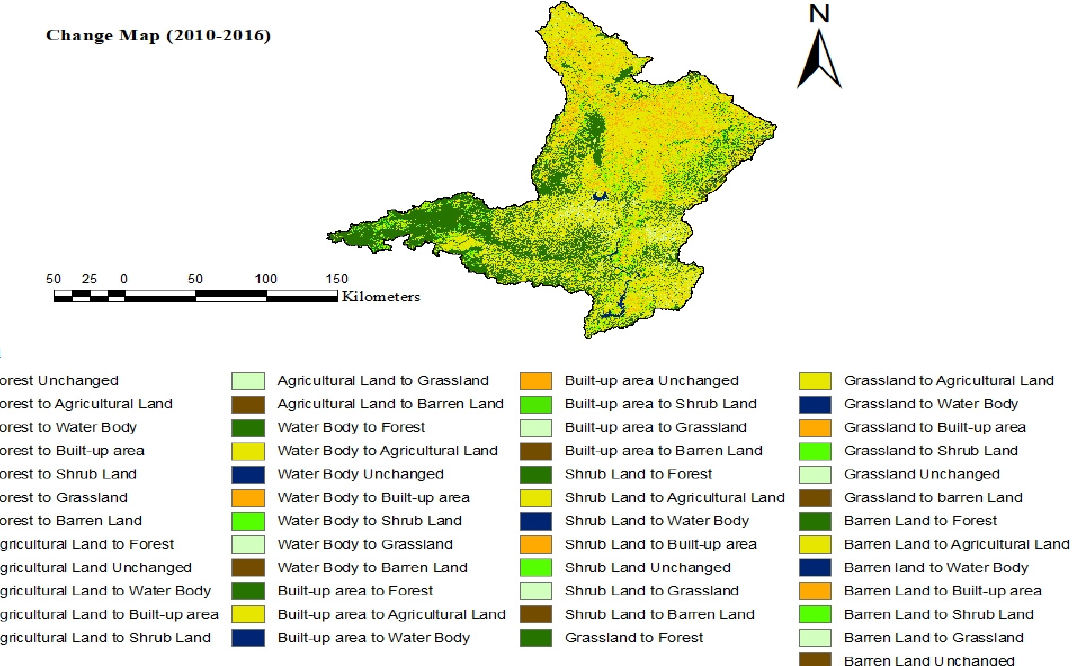
Figure 6. Change map (20102016) . Table 8. Transition matrix of 1991–2022 .